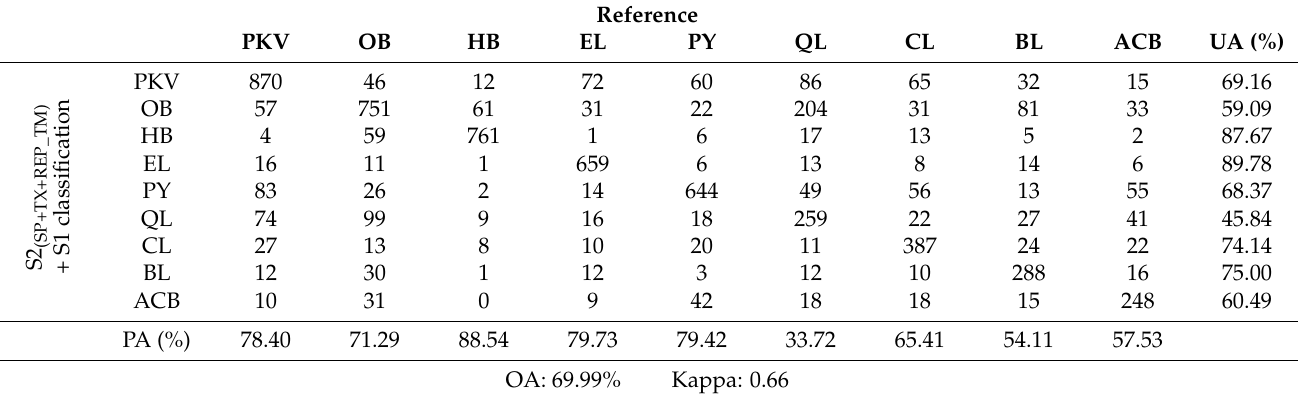
Table A4. Confusion matrix derived using Sentinel-2 and Sentinel-1 data.